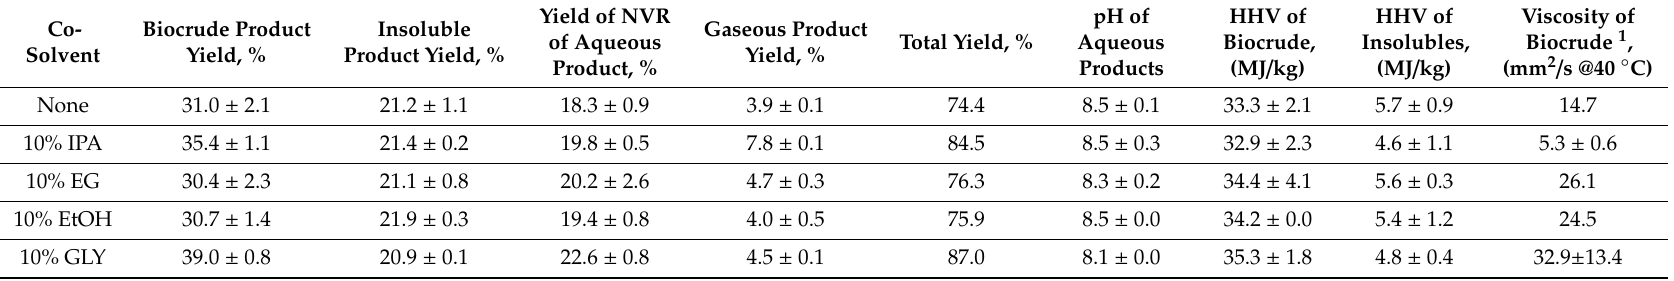
Table 2. Co-solvent e ff ects on product yields (wt%, dry basis) and properties from HTL treatment of Tetraselmis sp. at 350 ◦